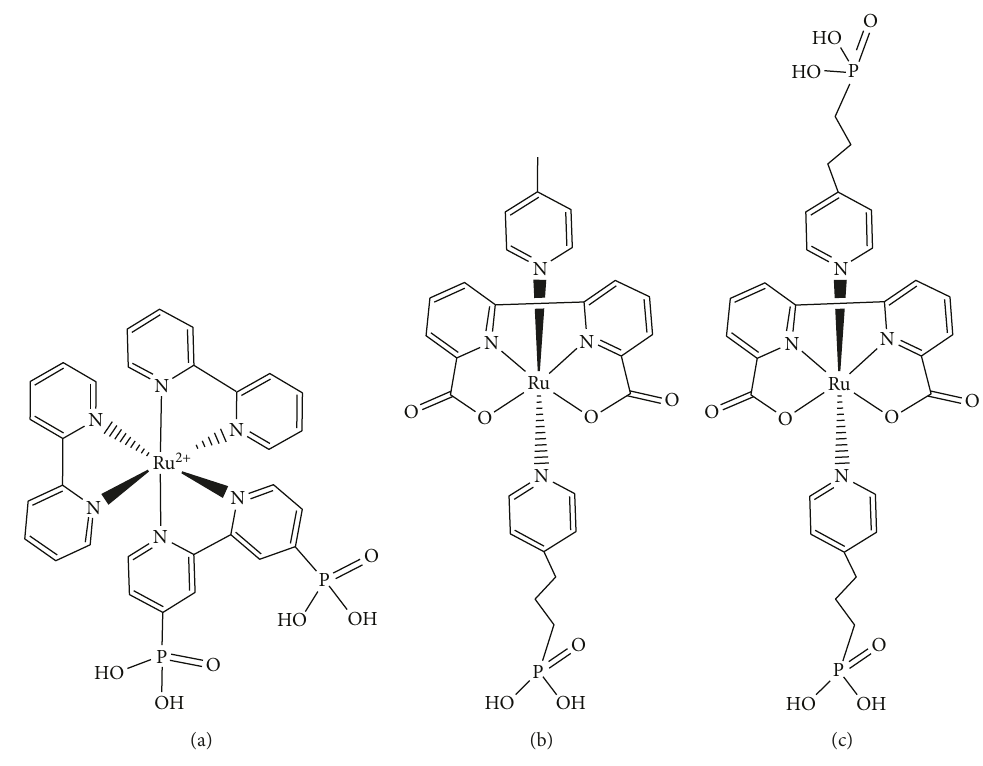
Figure 2: Structures of Ru(II)-based photosensitizer (a) and catalysts (b) and